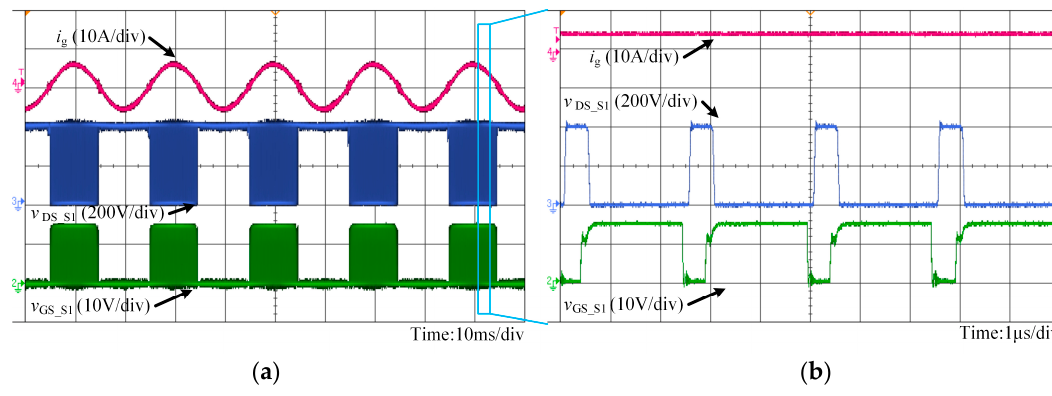
Figure 18. Experimental waveforms: ( a ) Waveform of the switch voltage and grid current at rated power; and ( b ) partial enlarged waveform of the switch voltage and grid current.